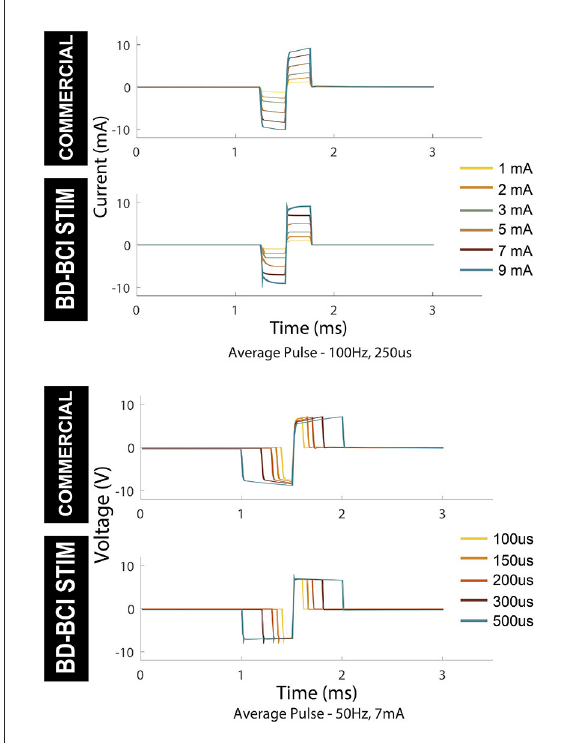
FIGURE6 Output comparison of current amplitude and pulse width of the commercial and BD-BCI stimulator. Parameter sweeping of current and pulse-width are performed. The pulses in 5 seconds pulse-train are time-aligned and overlaid to demonstrate the accuracy and consistency of the pulse